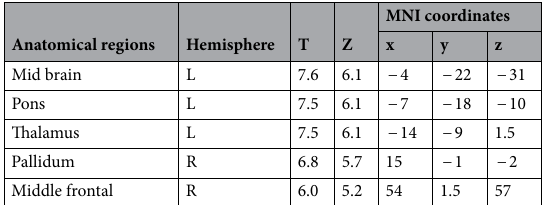
Anatomical regions